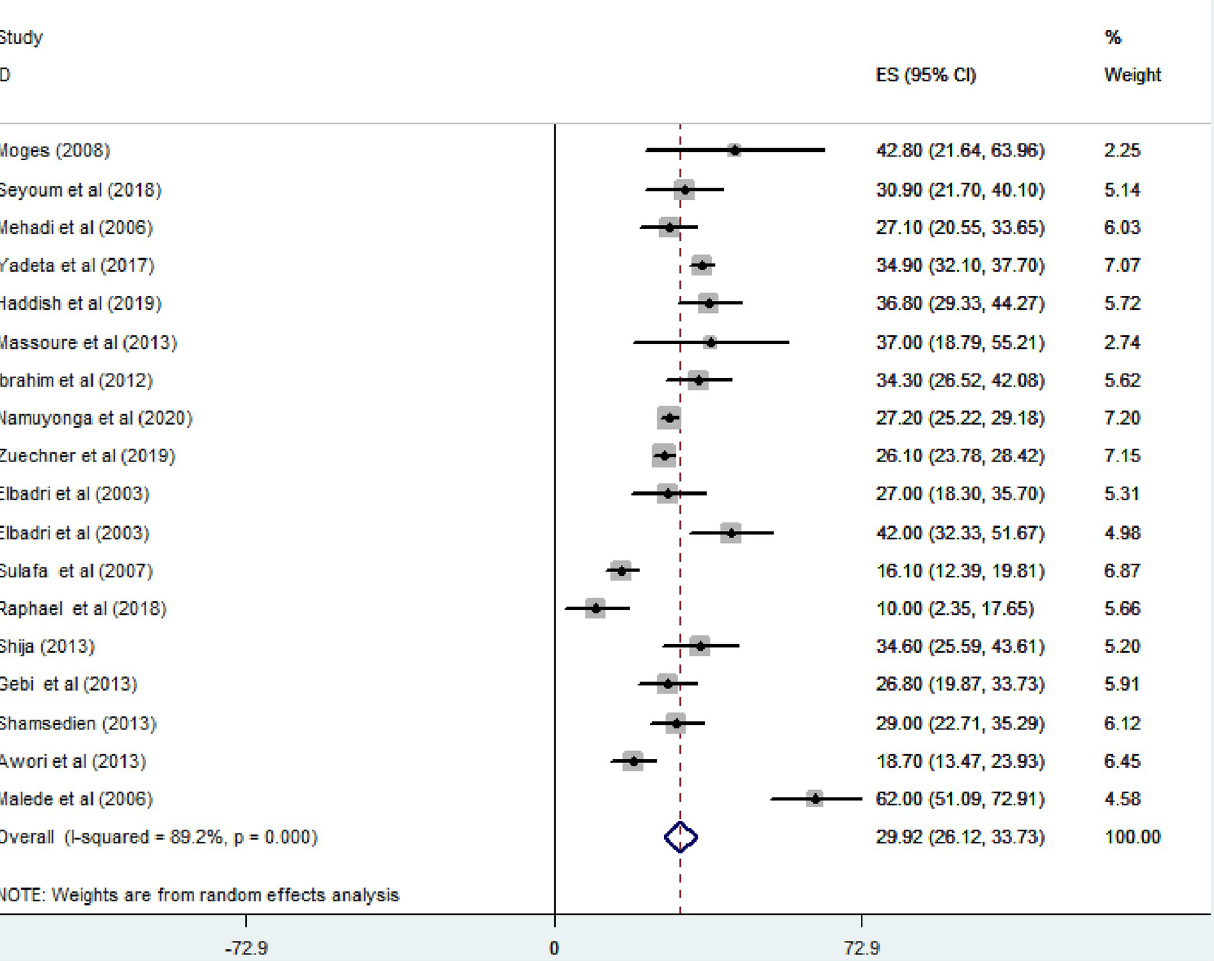
Fig 2. Forest plot showing the pooled magnitude of ventricular septal defect among congenital heart defect patients in East Africa, from January 2000-October 2020.